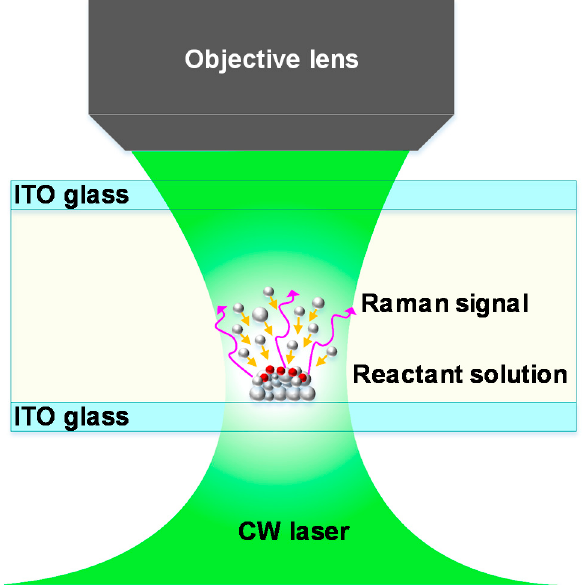
Figure 1. Schematic illustration of in situ photochemical deposition of silver nanoaggregates and SERS measurement. The gray and red spheres represent the silver atom and analyte molecule, respectively.